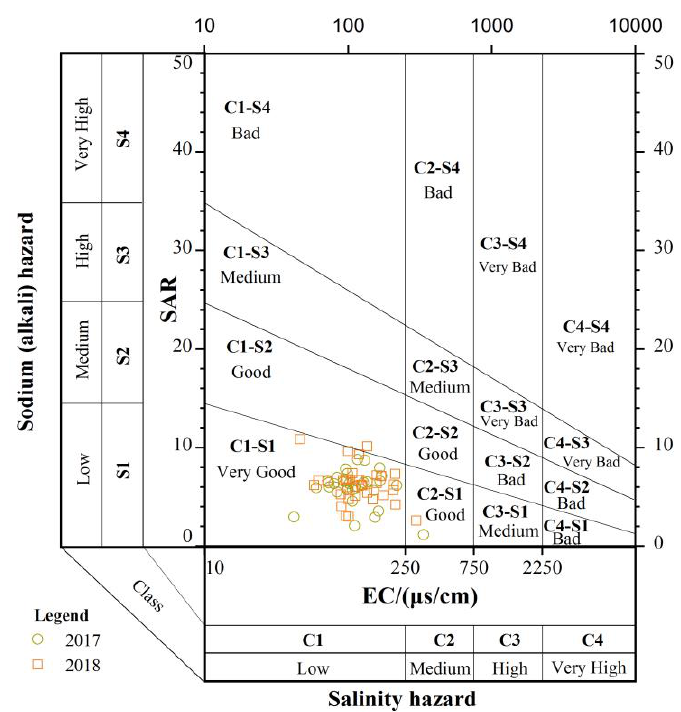
Figure 9. United States Salinity Laboratory (USSL) diagram for the classification of irrigation water (after the United States Salinity Laboratory [53] ).